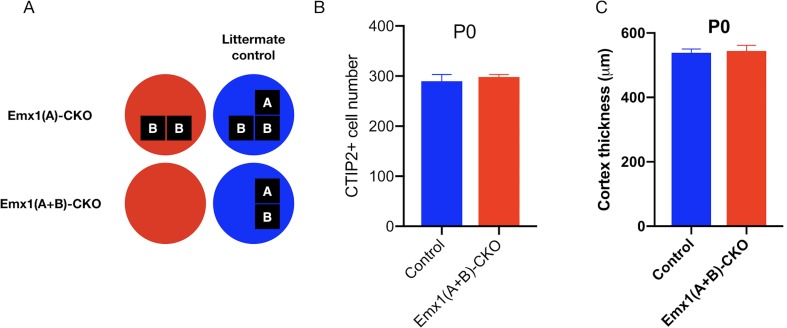
Emx1(A+B)-CKO mice do not exhibit neuropathological abnormalities at birth.(A) Illustration of examined genotypes. Each row of boxes within the circles denote the presence or absence of Tor1a (top row) or Tor1b (bottom row) alleles following Cre recombination. The presence of a letter (‘A’ or ‘B’) indicates an intact allele, whereas the absence of a letter indicates a deleted allele. (B) CTIP2 neuron counts in P0 Emx1(A+B)-CKO sensorimotor cortex. CTIP2+ neuronal counts in Emx1(A+B)-CKO mice do not differ significantly from littermate controls at P0 (non-parametric Mann-Whitney test U = 38.5, p=0.1911; control n = 13, Emx1(A+B)-CKO n = 9). (C) Cortical thickness measurements at P0 in Emx1(A+B)-CKO mice. Cortical thickness does differ significantly at P0 in Emx1(A+B)-CKO mutants (unpaired t-test t20 = 0.2663, p=0.7927; control n = 13, Emx1(A+B)-CKO n = 9).Figure 1—figure supplement 2—source data 1.Data on P0 characterization of Emx1(A+B)-CKO mouse brains.